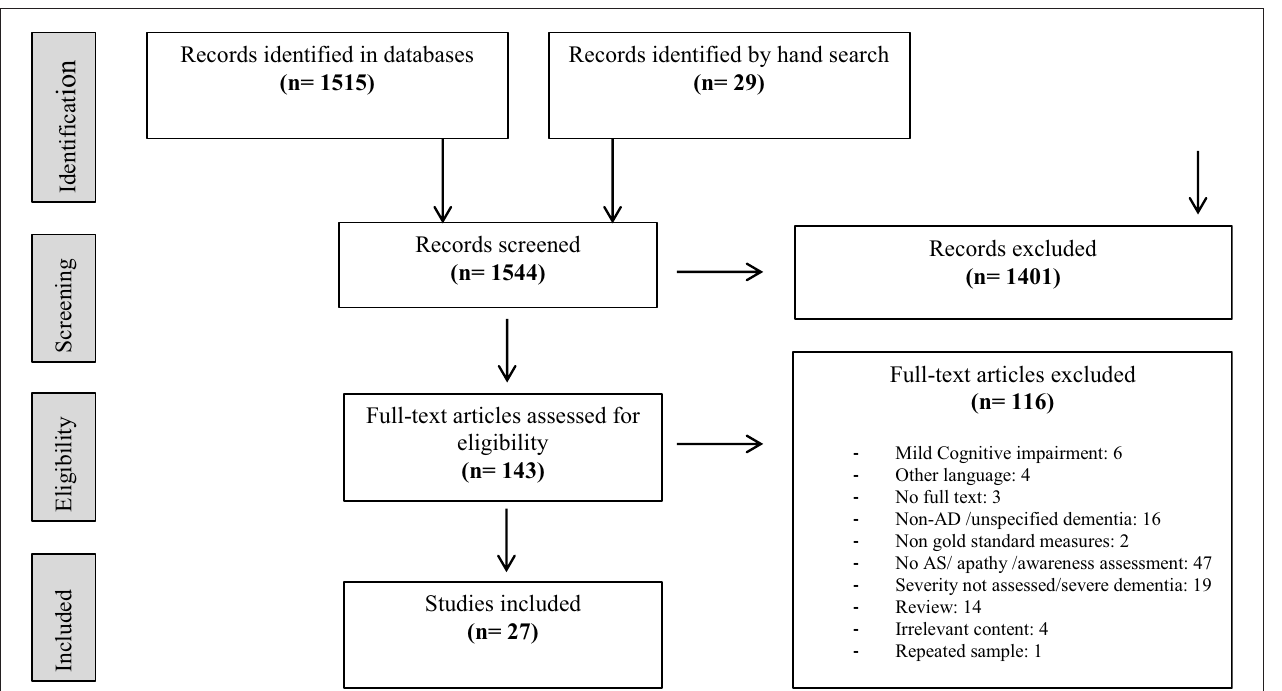
FIGURE 1 | PRISMA flow